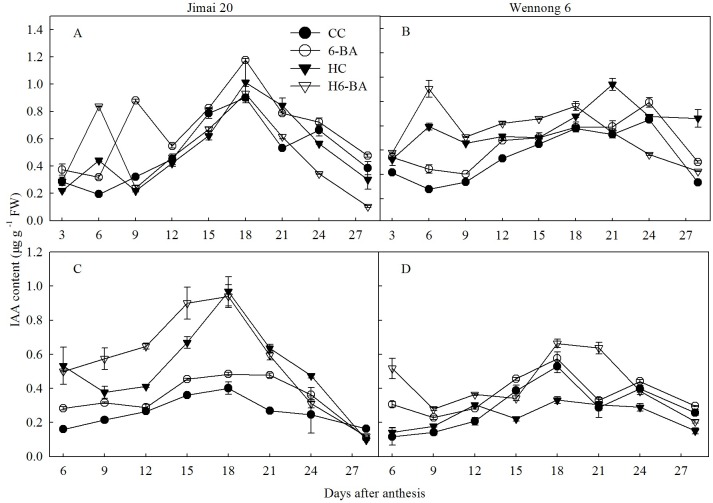
IAA content in superior (A, B) and inferior kernels (C, D).CC and 6-BA represent treatment with water and 6-BA under non-heated condition, respectively. HC and H6-BA represent treatment with water and 6-BA under heated condition, respectively. Vertical bars represent ± standard error of the mean (n = 3) where they exceed the size of the symbol.